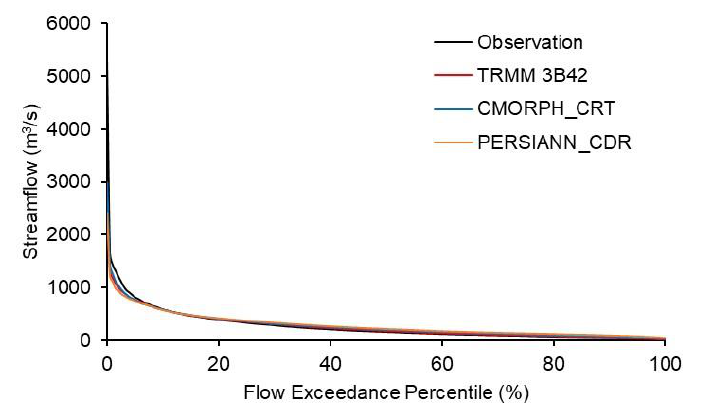
Figure 9. Simulated (red) and observed (black) daily streamflow under Scenario II from: ( a ) TRMM 3B42; ( b ) CMORPH_CRT; and ( c ) PERSIANN_CDR. Blue lines show precipitation data.